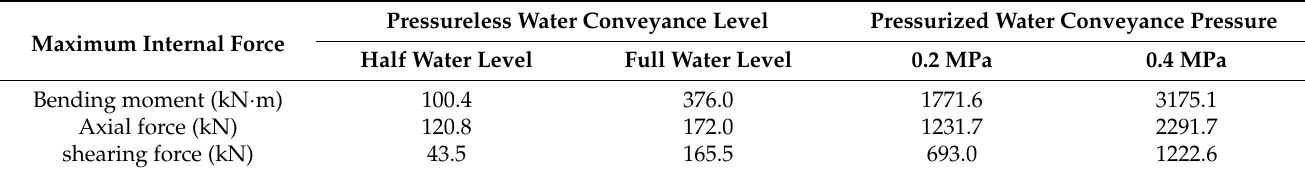
Table 2. The maximum internal force of flood discharging tunnel